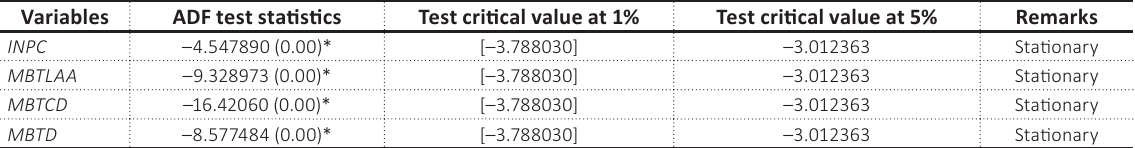
Table 3. PP test result at the second difference: intercept